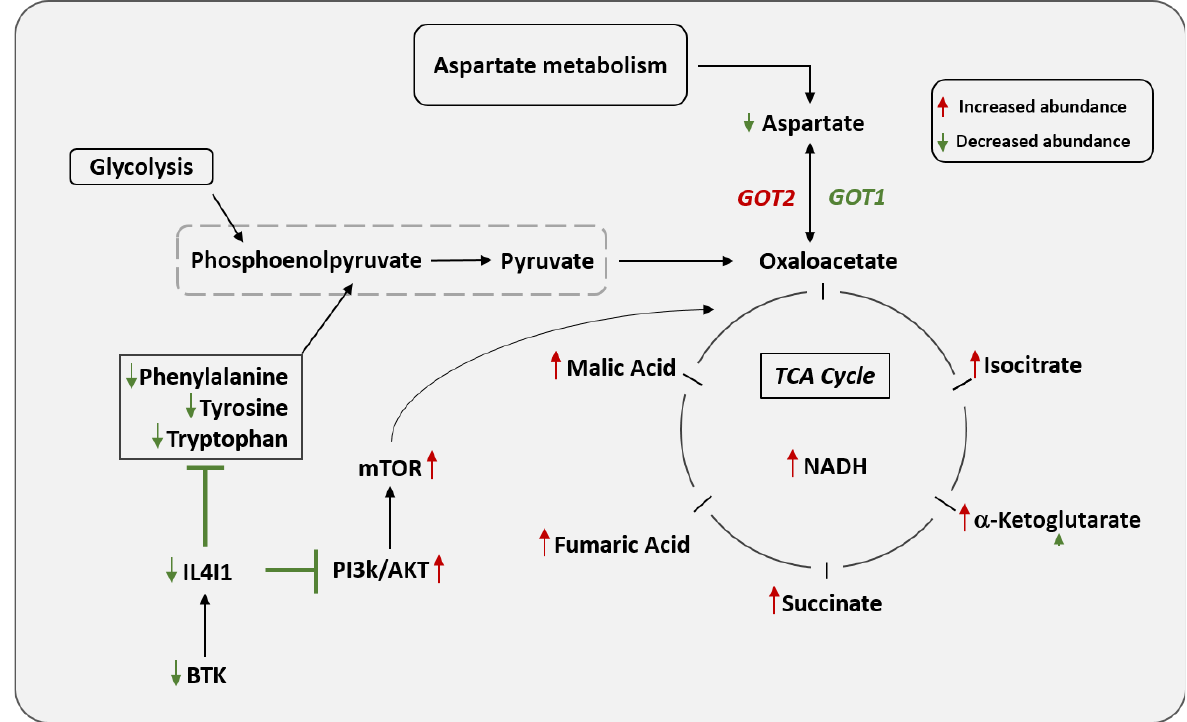
Figure 6. Proposed crosstalk of amino acid metabolism and TCA cycles within the ibrutinib resistance mechanism regulated by IL4I1. The proposed metabolic cross-talks in relation to TCA anaplerosis in drug-resistant lymphoma. Modulation of BTK and PI3K AKT pathways regulates the expression of IL4I1. Decreased IL4I1 expression affects phenylalanine metabolism, accompanied by decreased pyruvate levels, shifting to increased oxidative phosphorylation, and driving robust cell proliferation in drug-resistant lymphoma. One cannot exclude the possibility that ancillary metabolic pathways, such as the urea cycle as well as glutamate and glutamine metabolism, can directly contribute to TCA intermediates fumaric acid and α -ketoglutarate, respectively.